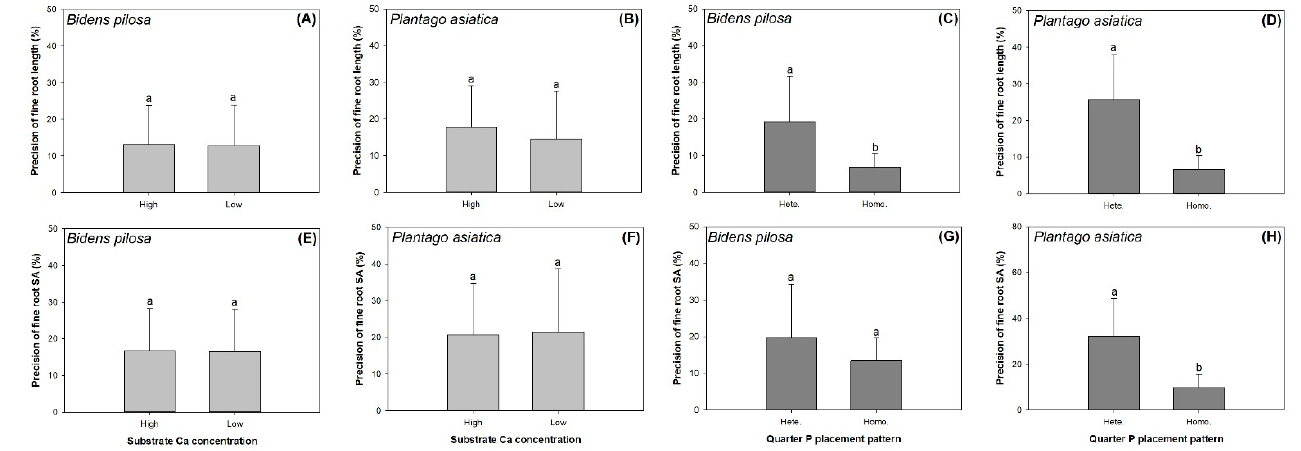
Figure 4. Fine root foraging sensitivity gauged as length ( A ‒ D ) and surface area (SA) ( E ‒ H ) in Bidens pilosa and Plantago asiatica plants subjected to phosphorus (P) input as heterogeneous (Hete.) and homogeneous patterns (Homo.) at high calcium (Ca) (2 g kg − 1 ) and low Ca levels (0.63 g kg − 1 ). Error bars stand for standard errors. Same letters in a cell of figure indicate the failure to find significant difference by Duncan’s new multiple range test at the p < 0.05 level.